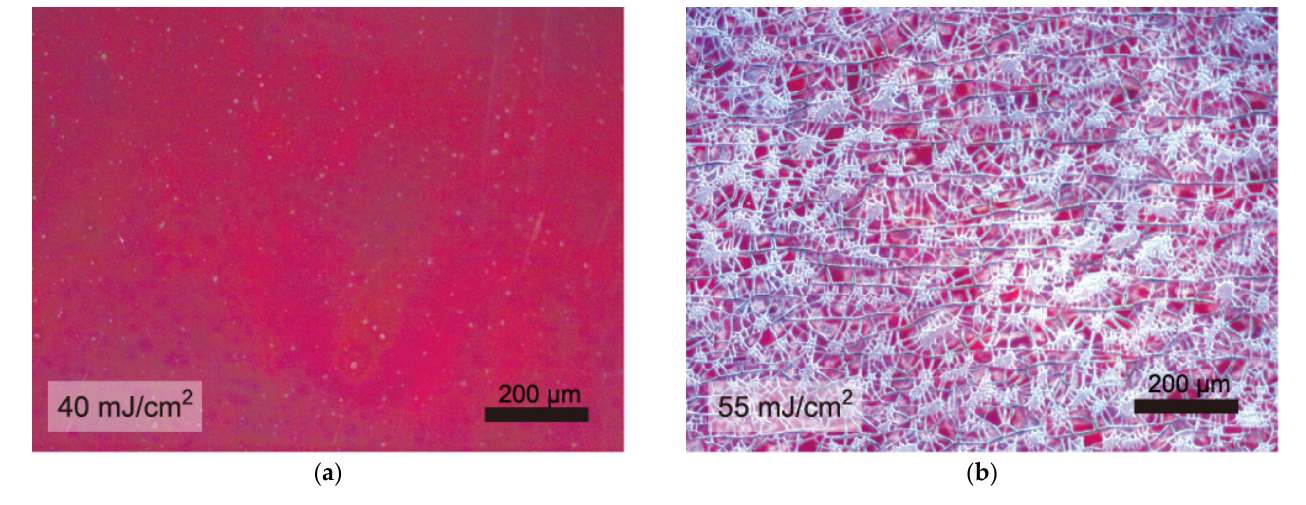
Figure 4. Optical microscope images for RLNO/BTO/PI prepared by KrF laser irradiation at ( a ) 40 mJ·cm − 2 and ( b ) 55 mJ·cm − 2 .